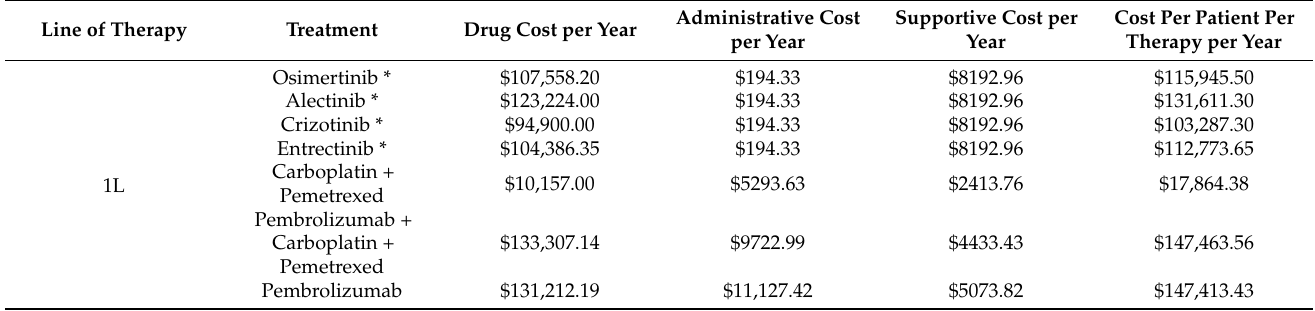
Table A1. Annual cost per patient per